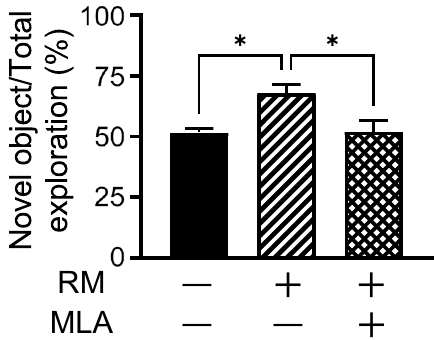
Figure 4. Rice-memolin improves cognitive decline depends on the acetylcholine system. Mice were fed HFD for a week and rice-memolin was administered orally at a dose of 1 mg/kg (once a day for 3 days) with or without administration of methyllycaconitin (MLA), an antagonist for α7 nicotinic acetylcholine receptor, at a dose of 0.3 mg/kg. Thereafter, the novel ORT was performed. All values are means ± SEM (n = 3–5). * P < 0.05, ** P < 0.01, *** P < 0.001 vs. HFD group. RM: